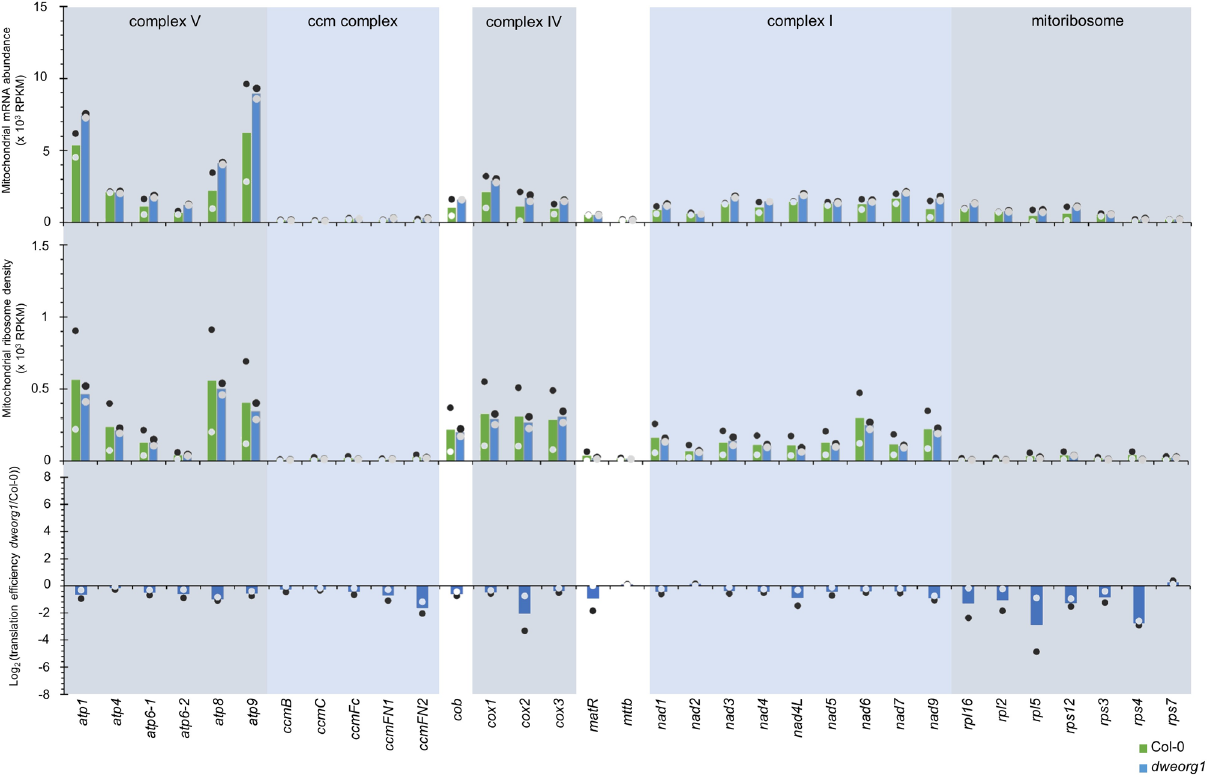
Figure 3. Mitochondrial mRNAs over-accumulate in the dweorg1 mutant, while the ribosome densities along the mitochondrial mRNAs are reduced. Comparative mitochondrial mRNA levels in wild type and dweorg1 mutant plants given as RPKM obtained via RNA-seq analysis. Comparison of ribosome densities along mitochondrial mRNAs in wild type and dweorg1 mutant plants given as RPKM obtained via Ribo-seq. Log 2 ratios of normalized ribosome footprint abundance in the wild type relative to the dweorg1 mutant for each mitochondrial mRNA. The values were normalized to the number of Ribo-seq read mappings to the nuclear ORFs, and the abundance of each mRNA was determined via